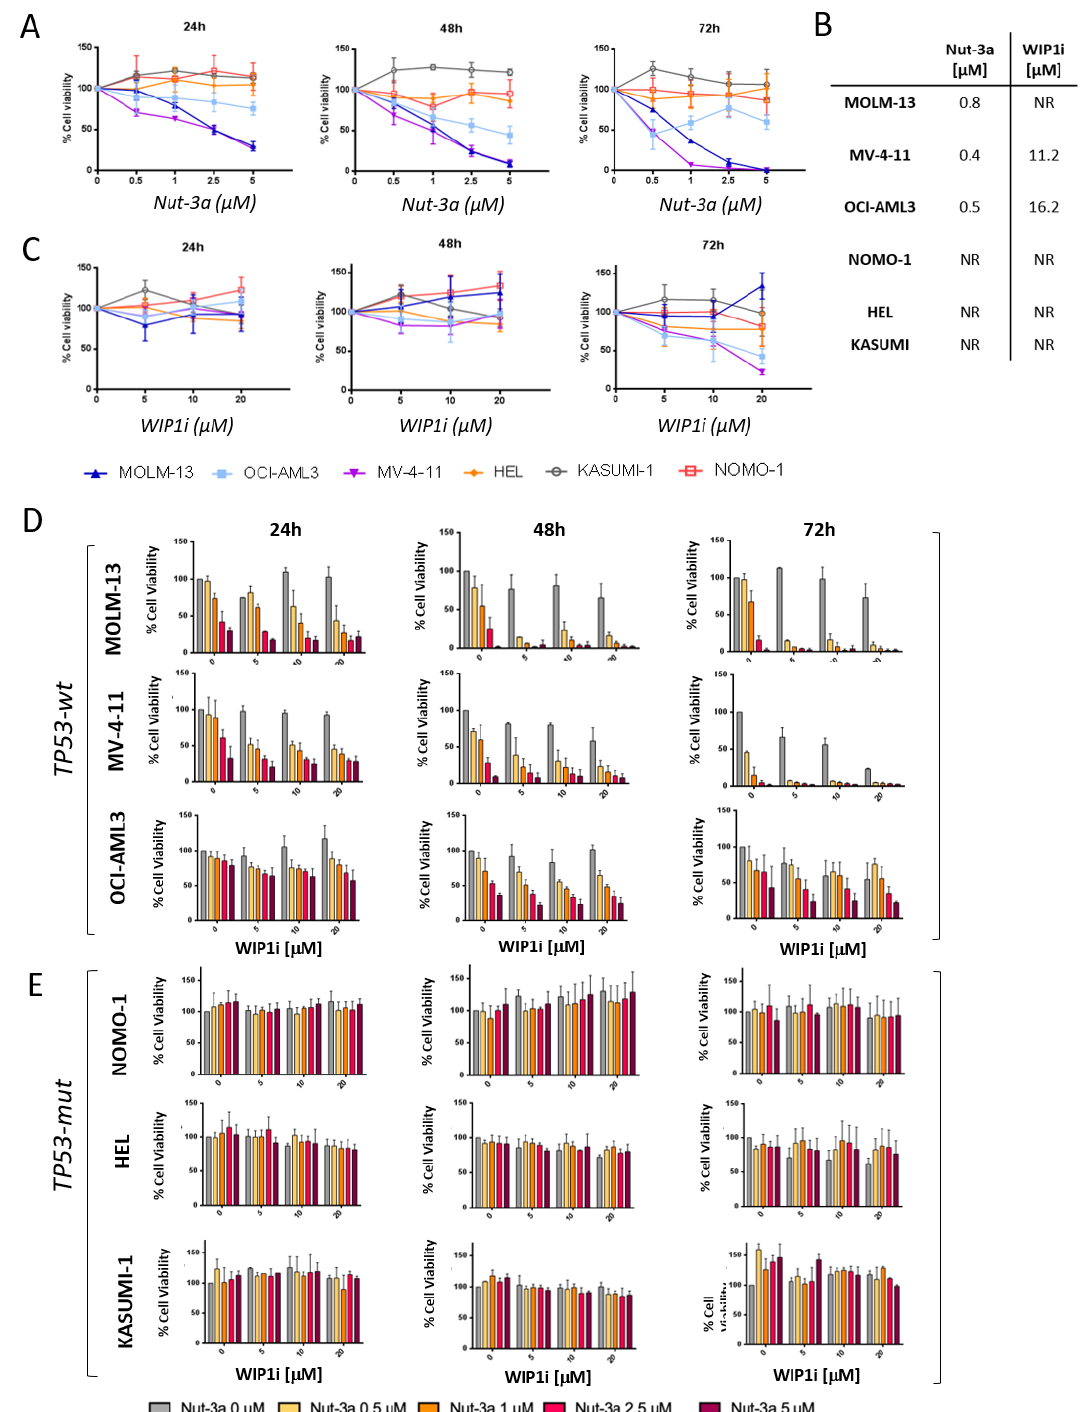
Figure 2. Viability of AML cell lines treated with Nut-3a and/or WIP1i. ( A ) Percentage of viable MOLM-13, MV-4-11, OCI-AML3, NOMO-1, HEL and KASUMI-1 AML cells treated with increasing concentrations of single agent Nut-3a (from 0.5 to 5 µ M) for 24, 48 and 72 h. ( B ) IC50 values of AML cell lines at 72 h of treatment with Nut-3a or WIP1i (NR = not reached). ( C ) Percentage of viable cells treated with increasing concentrations of single agent WIP1i (from 5 to 20 µ M) for 24, 48 and 72 h. Inhibition of cell viability induced in TP53 -wt ( D ) and TP53 -mut ( E ) AML cell lines by the combination of increasing concentrations of Nut-3a (from 0.5 to 5 µ M) and WIP1i (from 5 to 20 µ M) at 24, 48 and 72 h. Average value and standard deviation of 3 independent experiments are